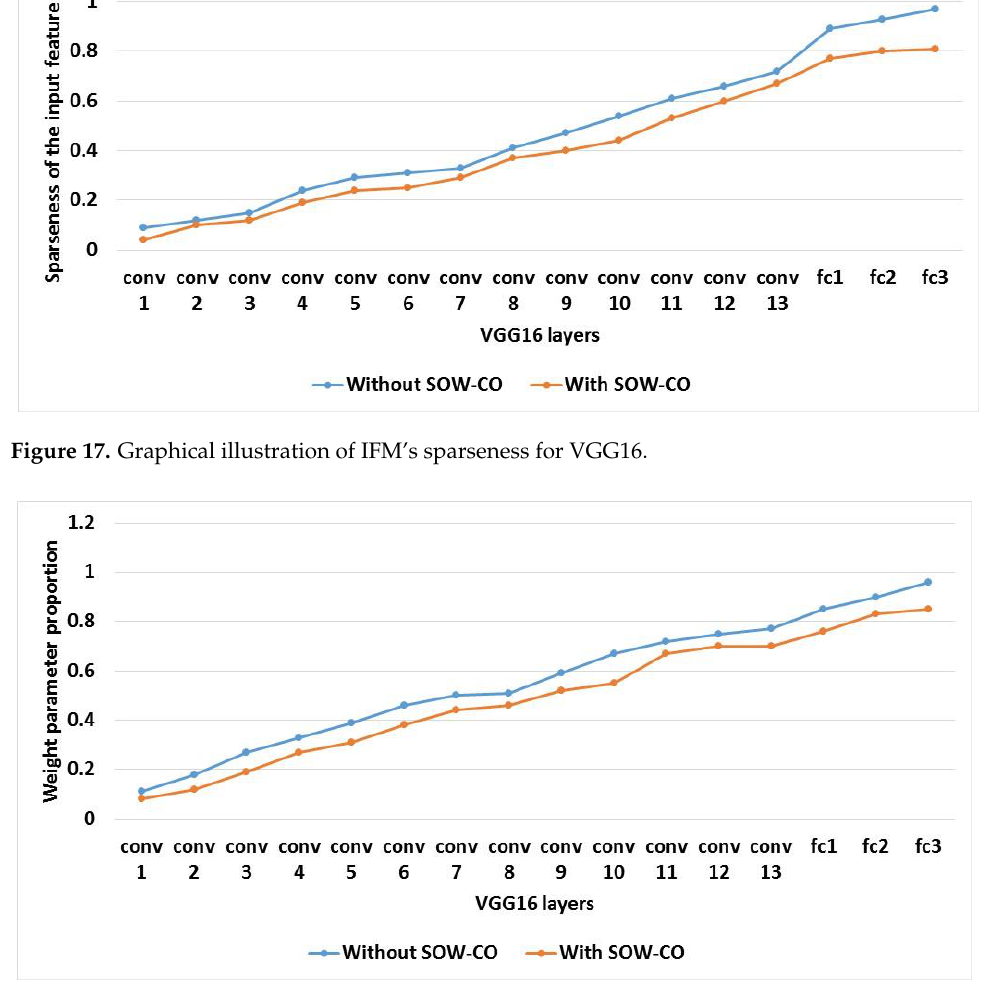
Figure 18. Graphical illustration of weight parameter proportion for VGG16. An evaluation of sparseness of the IFM and weight parameter proportion for RCNN- VGG19 with and without SOW-CO is shown in Table 7. The graphical illustrations of the IFM’s sparseness and weight parameter proportion for RCNN -VGG19 are shown in Fig- ures 19 and 20, respectively. This analysis shows that the IFM’s sparseness and weight parameter proportion of RCNN-VGG19 with SOW-CO are less when compared to the RCNN-VGG19 without SOW-CO. Table 7. Analysis of sparseness of the IFM and weight parameter proportion for VGG19.